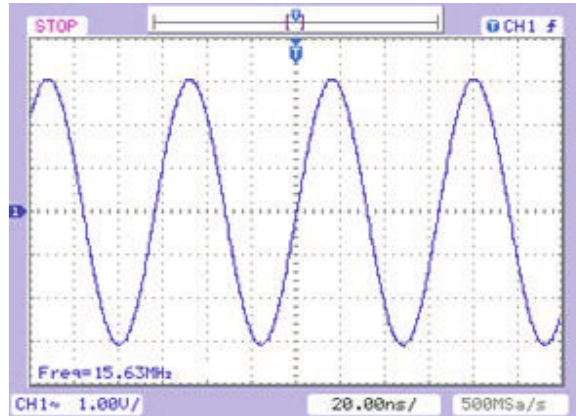
Figure 9: The sine wave signal of the high-speed